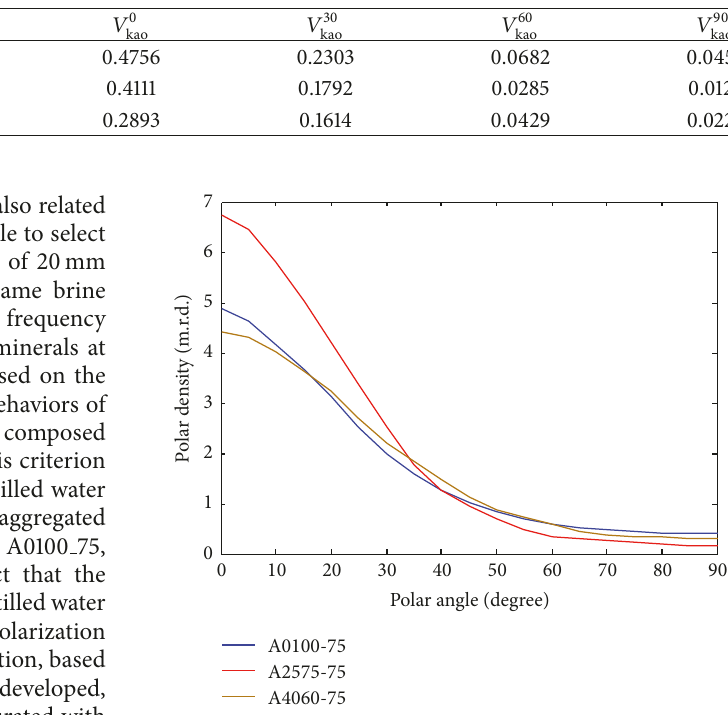
Table 1: Volume fractions of the rock-forming components for the model input of the 3 samples under investigation. The volume fractions are determined based on the measured sample porosity, the solid silt to kaolinite ratio, and the obtained orientation distribution function of the kaolinite grains.